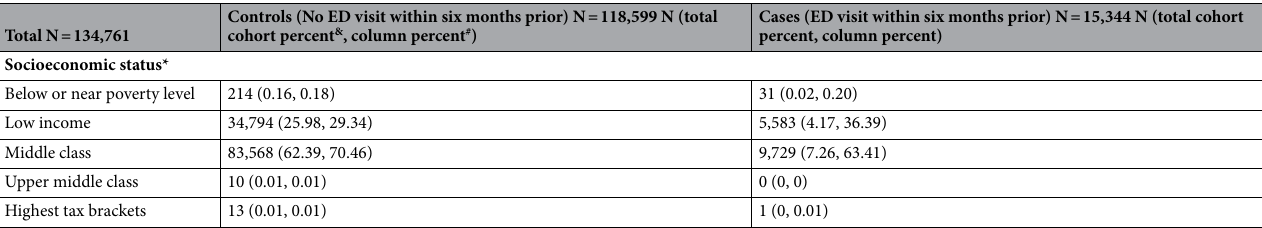
Table 3. Socioeconomic status for controls vs. cases. *See text for description of socioeconomic class, ** P < 0.001 estimated by Chi-square, & total cohort percent is the column value divided by the N total (137,761), # column percent is the column value divided by the column’s total N.